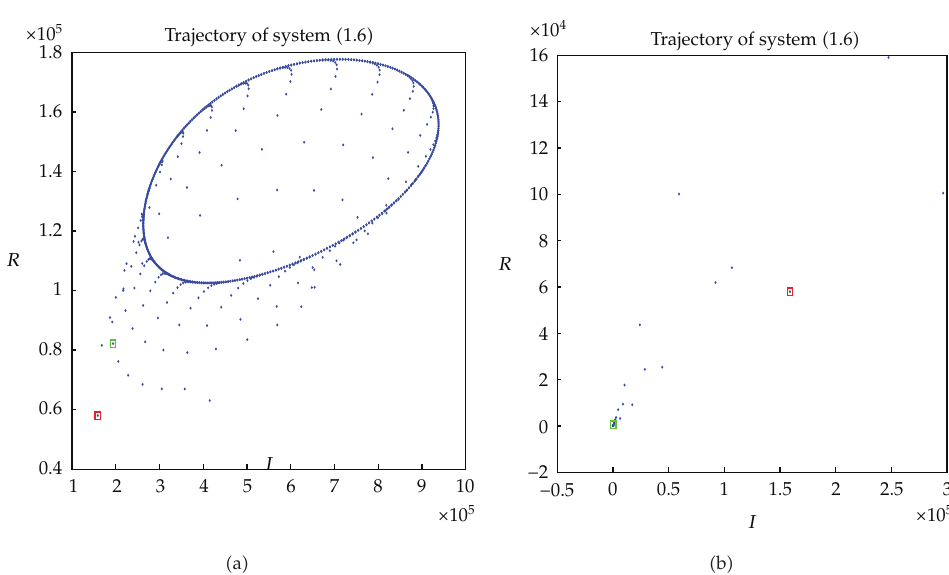
(cid:5) − γ (cid:2) 1 (cid:7) α/σ (cid:5) (cid:7) 1 > 0. 1